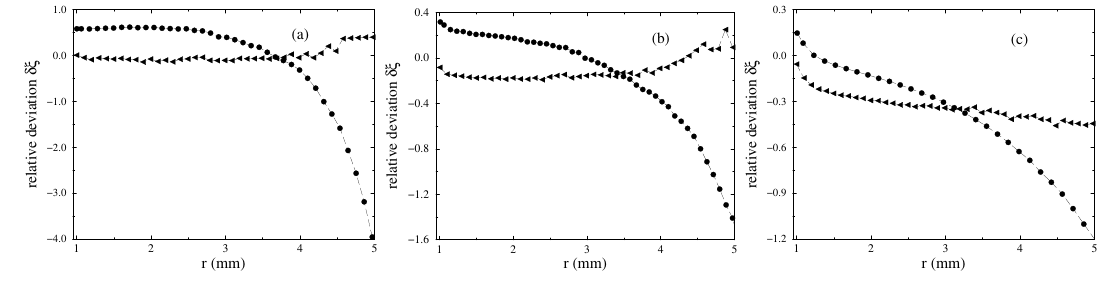
Figure 8. Relative deviation δξ using a nonlinear law of magnetisation in two-dimensional ( • from [19]) and three-dimensional ( (cid:74) ) simulations, respectively: ( a ) H = 3.35 kA/m, ( b ) H = 7.54 kA/m and ( c ) H = 11.73 kA/m at R = 0.95 mm. The long dashed lines are guides for the eye. Note the different scales at the axes of